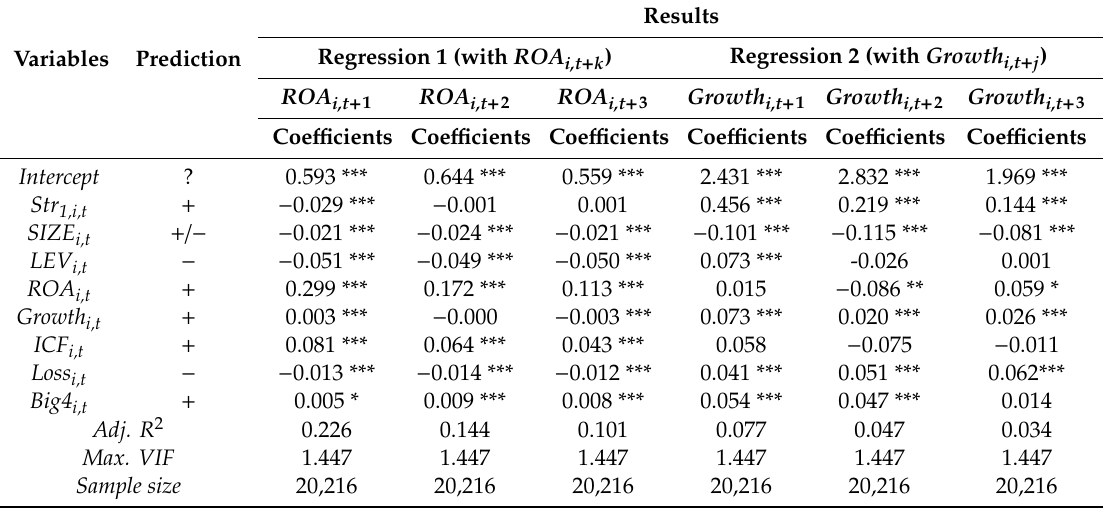
Table 6. Regression of future performance ( ROA i,t + k ) and growth sustainability ( Growth i,t + j ) on marketing e ff orts ( Str 1, i,t ) a .